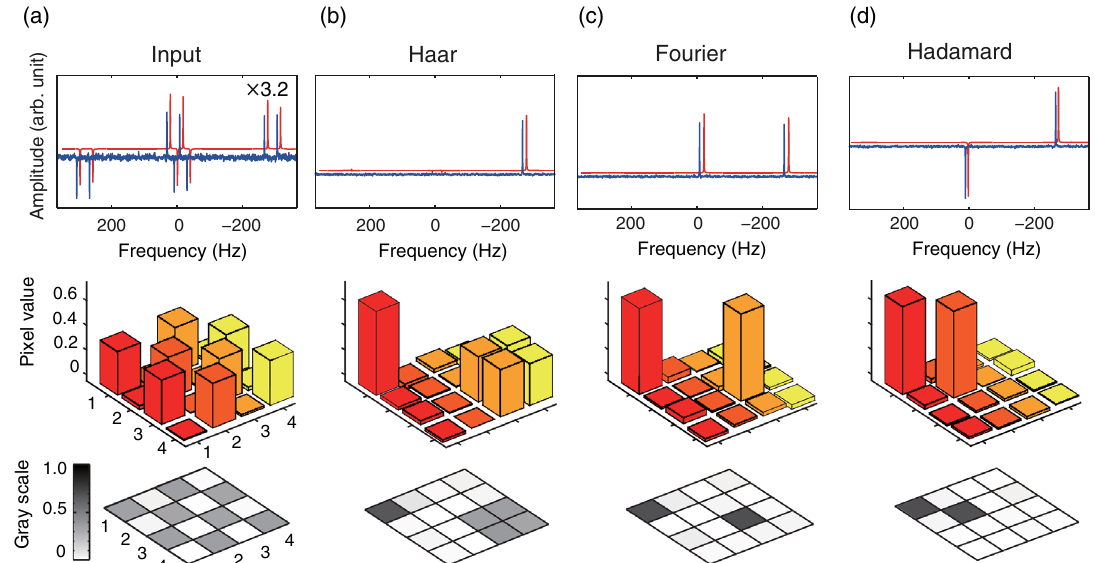
FIG. 5. Experimental results of quantum image transformations. (a) Input 4 × 4 image, (b) Haar-transformed image, (c) Fourier- transformed image, (d) Hadamard-transformed image. In (a), the spectral amplitude is zoomed-in by 3.2 times. The experimental spectra (top) of the 13 C qubit were obtained by π = 2 readout pulses, shown as blue curves. The simulated spectra are denoted as red curves, shifted for clarity. The experimentally reconstructed images (only real parts are displayed since all imaginary parts are negligibly small) are shown as 3D bar charts (middle). Their 2D gray scale (visual intensity) pictures (bottom) are displayed with each square representing one pixel in the